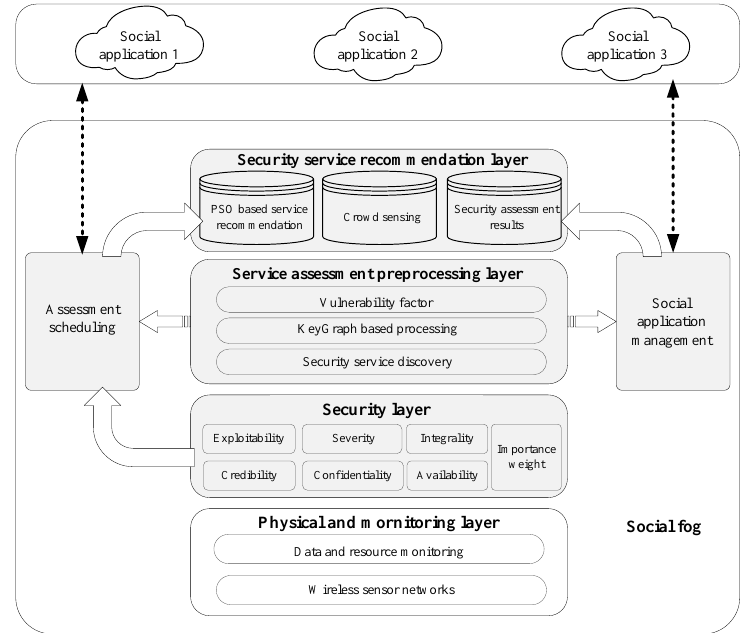
Figure 2. Node structure of social fog.